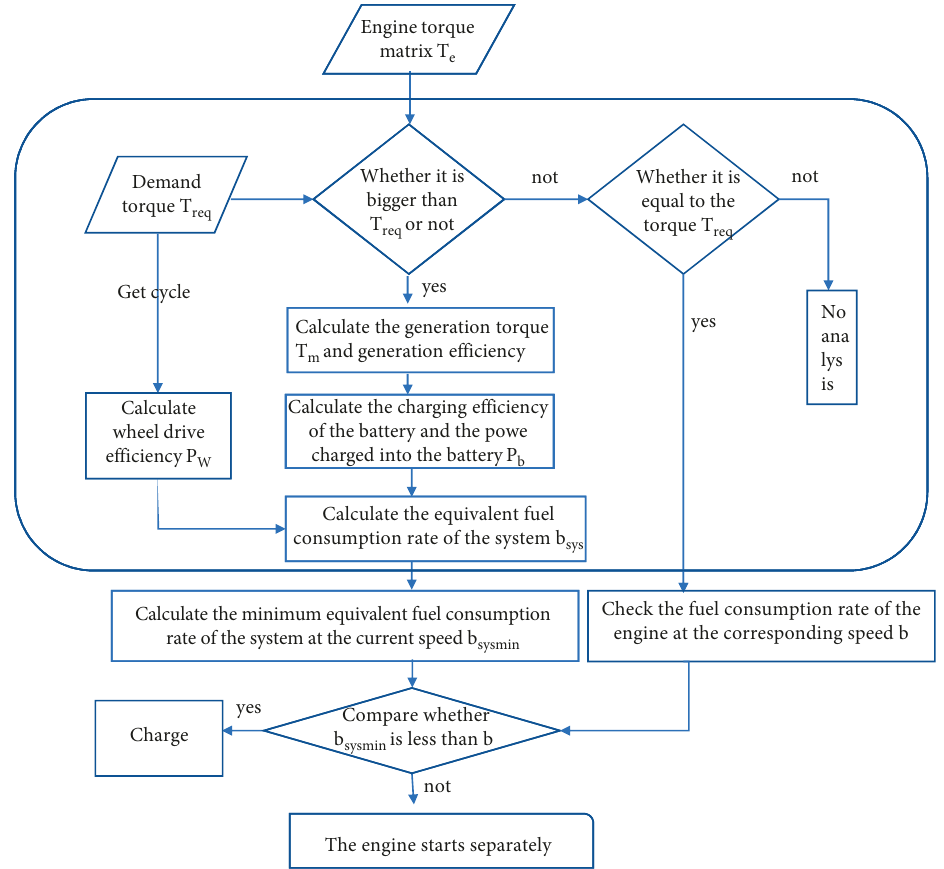
Figure 11: Rule-based energy management control